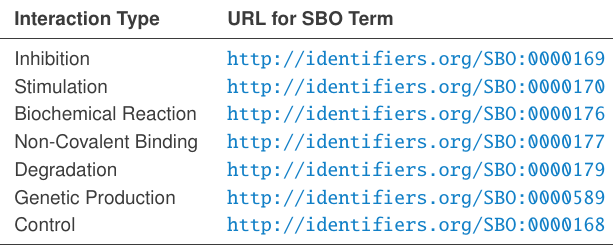
Table 11: Partial list of SBO terms to specify the type property of an Interaction .